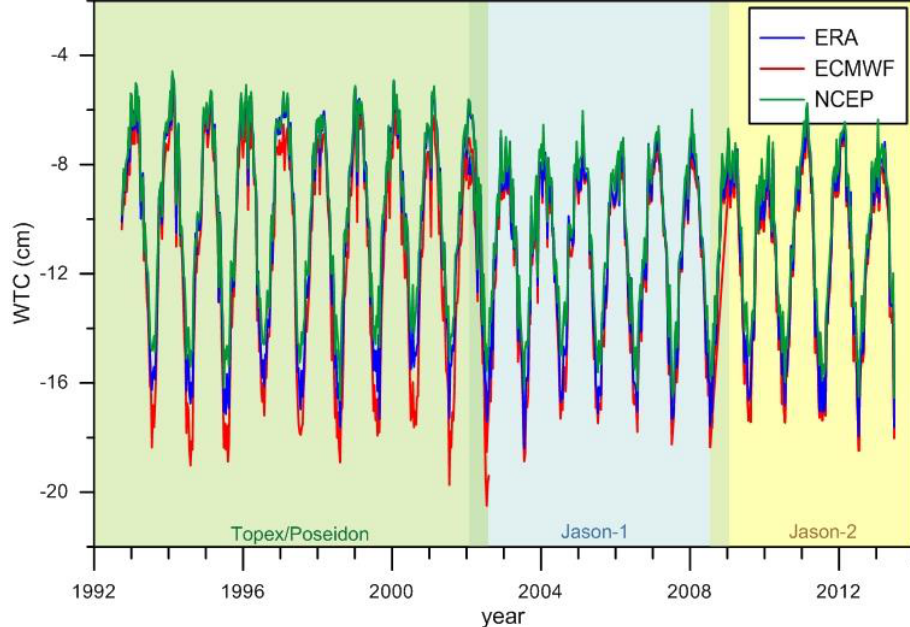
Figure 8. Global mean WTC for each 10-day cycle from three models as present in RADS, for all inland water points extracted as described in Section 2.1.2: ECMWF operational (red), ERA Interim (blue) and NCEP (green), for T/P Phase A, Jason-1 Phase A and